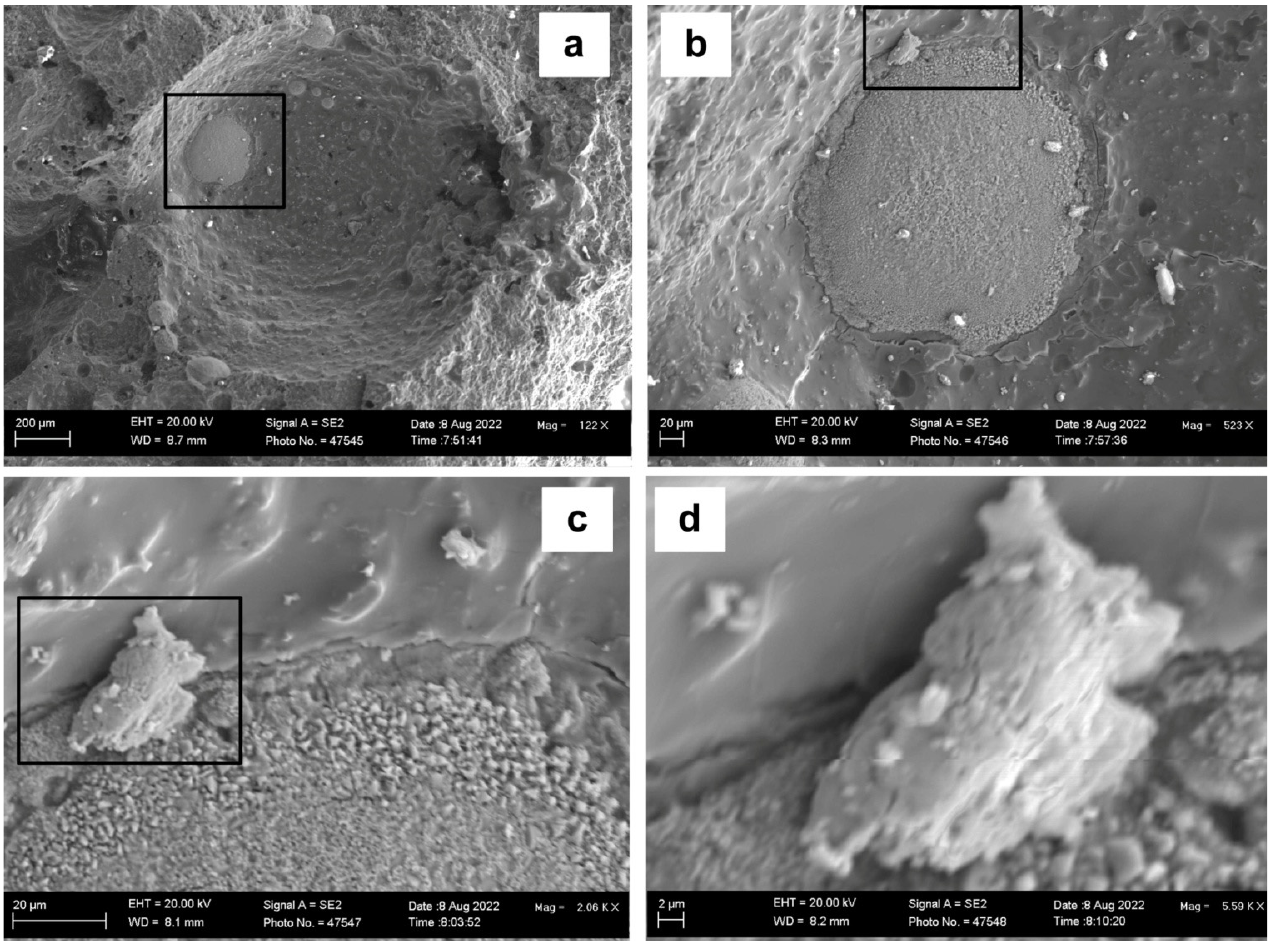
Figure 1. Analysed XRD patterns of post-weld slags in Table 3.